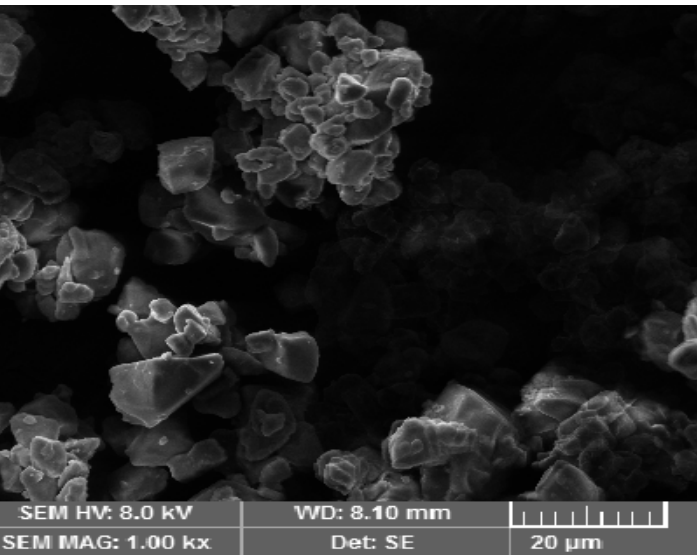
Figure 2. SEM image of the methotrexate-loaded nanoemulsion gel optimized